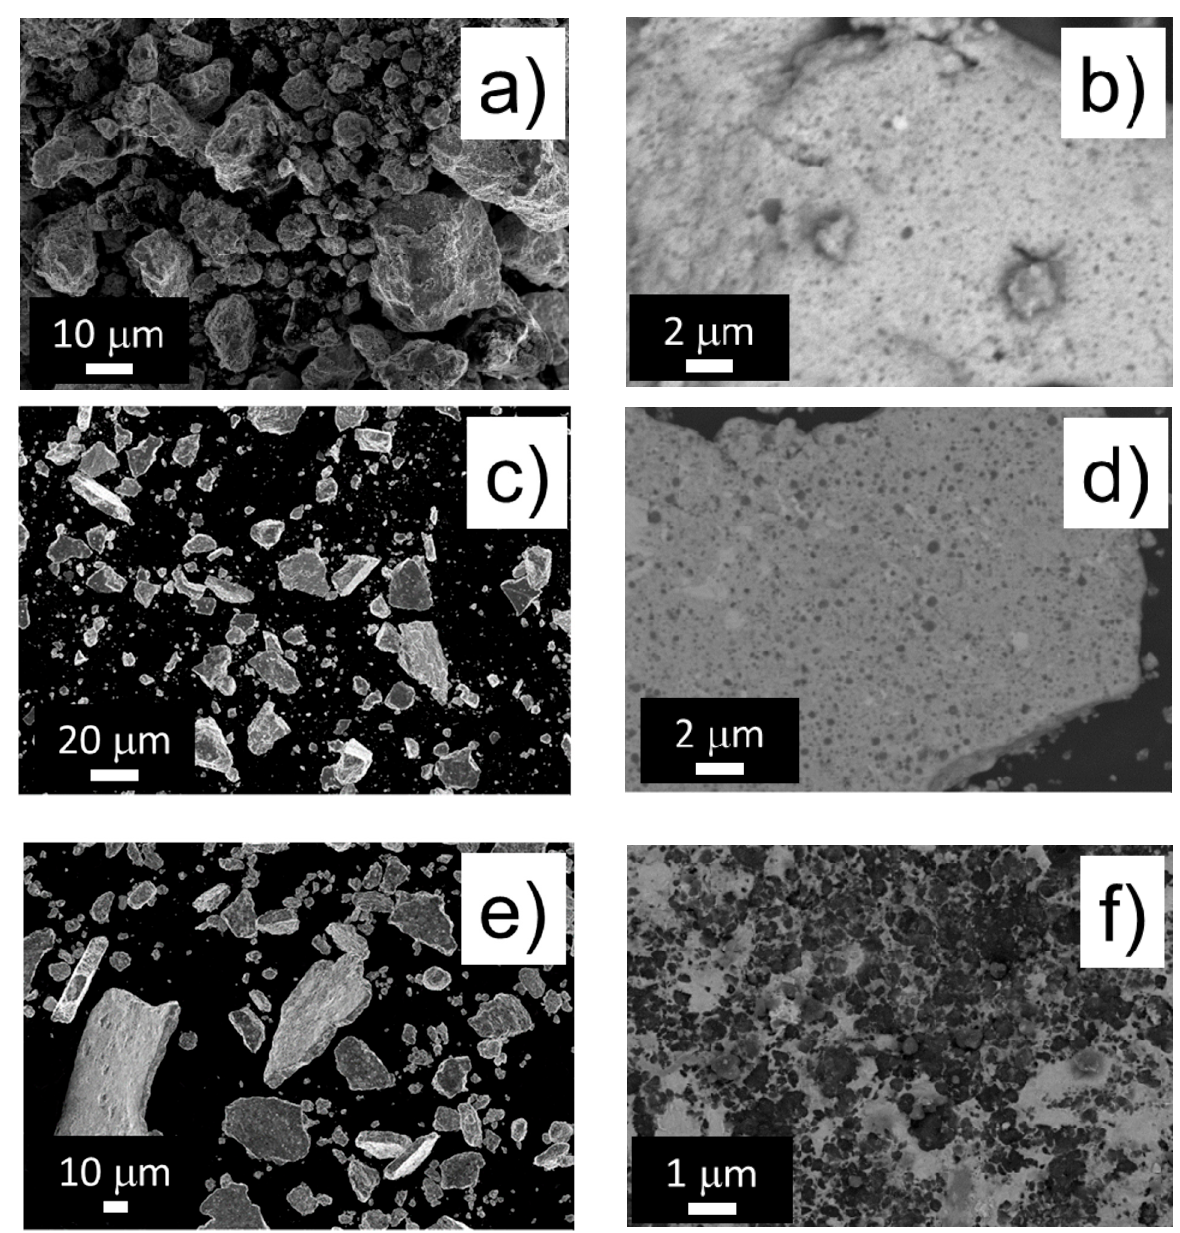
Figure 3. Scanning Electron Microscopy (SEM) images for Si R -NiSn ( a , b ) Si C -NiSn ( c , d ) and Si O -NiSn ( e , f ) composites. Images were taken in either Secondary Electrons (SE) ( a , c , e ) or Back-Scattered Electrons (BSE) ( b , d , f ) modes .